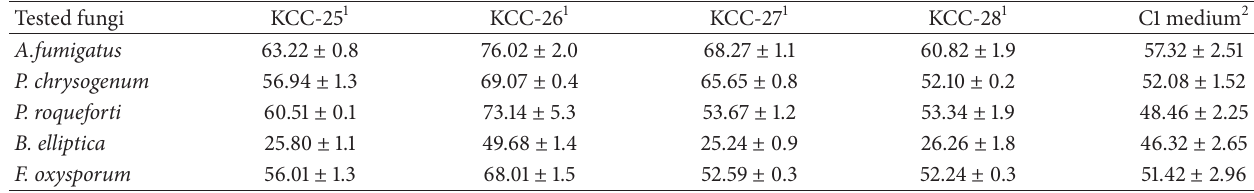
Table 3: Percentage of fungal inhibition by fermentative metabolites of KCC-25, KCC-26, KCC-27, and KCC-28. Tested